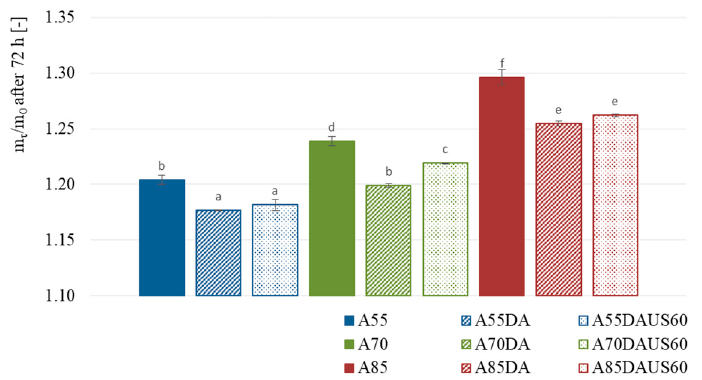
Figure 4. Mass gain after 72 h of moisture adsorption by the dried apples obtained by the convective method with non-dehumidified air, dehumidified air, and dehumidified air with ultrasound pretreatment; the same letters (a, b, etc.) in the columns represent homogeneous groups in statistical terms ( α = 0.05).